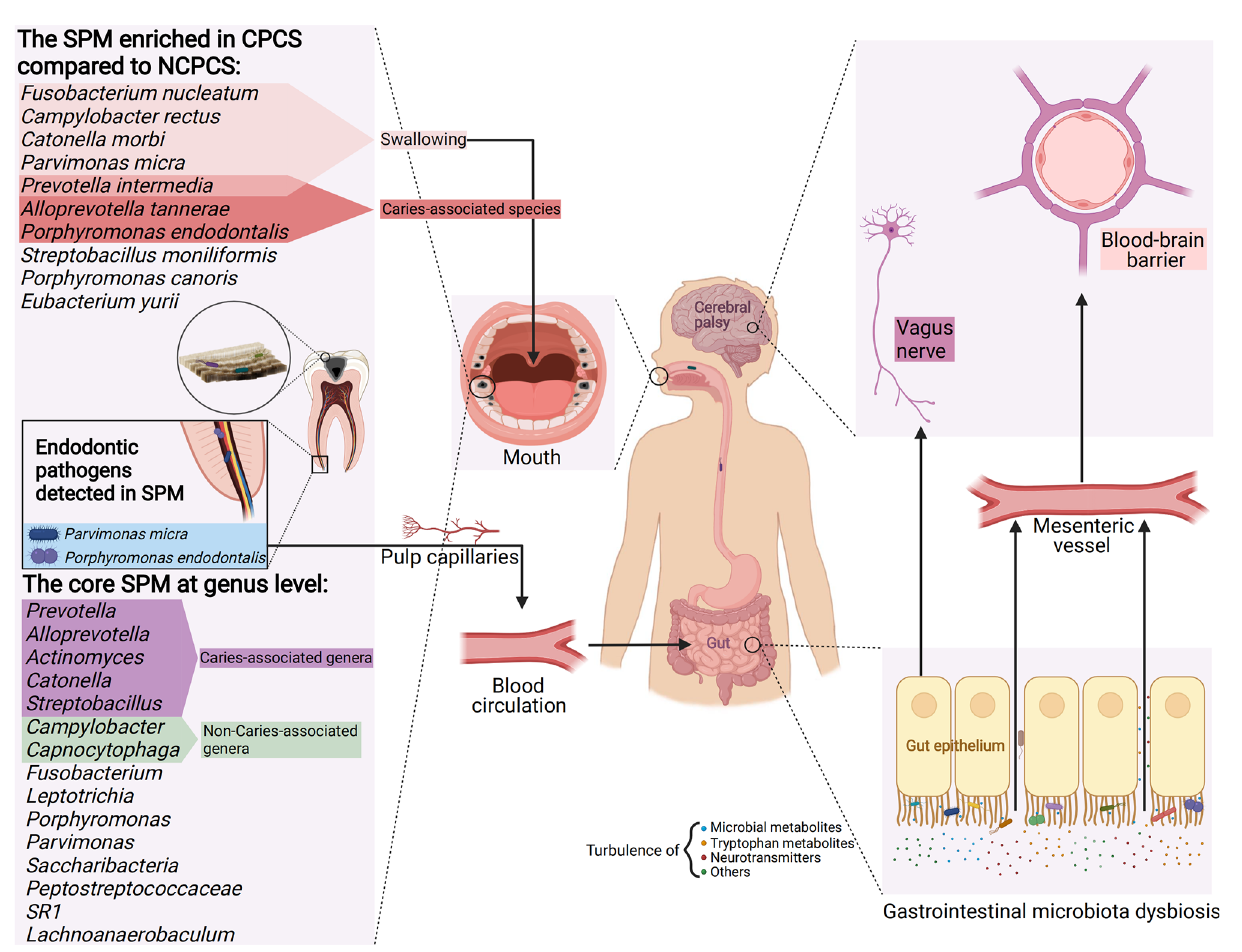
FIGURE 7 | A model of CP ’ s SPM and its potential impact on gastrointestinal microbiota dysbiosis and the gut – brain axis. The enriched genera in CPCS compared with NCPCS and the core genera (dominant in CPCS, CPCM, and CPCF) detected in the SPM of CP children are presented. SPM reaches the stomach and intestines by enteral (e.g., eating and swallowing) and hematogenous route (e.g., invasion of pulp capillaries through the root canal). Enriched in the SPM of CP, aciduric bacteria may survive the barrage of gastric acid and colonize in the gastrointestinal tract, thus establishing microbial dysbiosis and chronic in fl ammation. Through the vagus nerve pathway (neurotransmitters turbulence, e.g., GABA and acetylcholine), tryptophan metabolism (e.g., quinolinic acid and kynurenic acid) and microbial metabolite disorder (e.g., SCFA, peptidoglycans), developmental brain defects, and neuroin fl ammation and neurodegenerative diseases might be induced, thus aggravating neurological symptoms in CP children (Created with